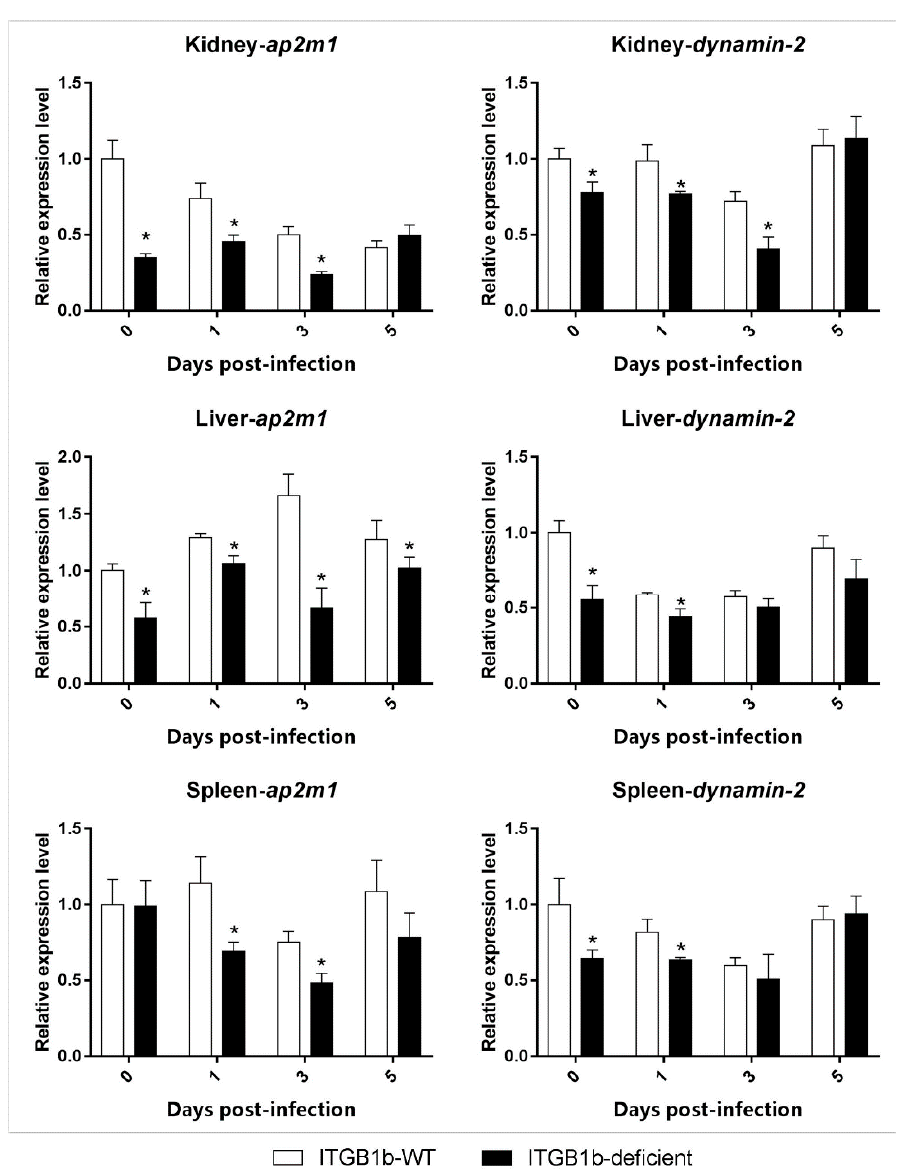
Figure 5. Expression of clathrin-related genes in ITGB1b-deficient and wild-type rare minnows. The relative expression levels were calculated as the ratio of gene expression level in ITGB1b-deficient fish relative to that in wild-type fish at 0 dpi. A significant difference ( p < 0.05, ANOVA) in gene expression level between the wild-type and ITGB1b-deficient rare minnows is indicated with an asterisk (*). Moreover, the level of jam-a and caveolin-1 expression during the infection did not significantly differ between the two groups (Figure 6).